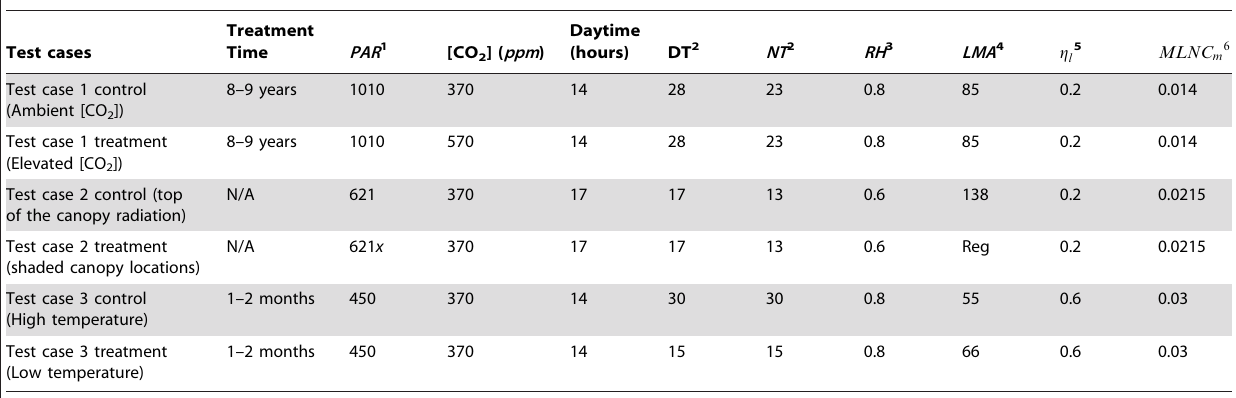
Table 1. Main model inputs for three test cases.